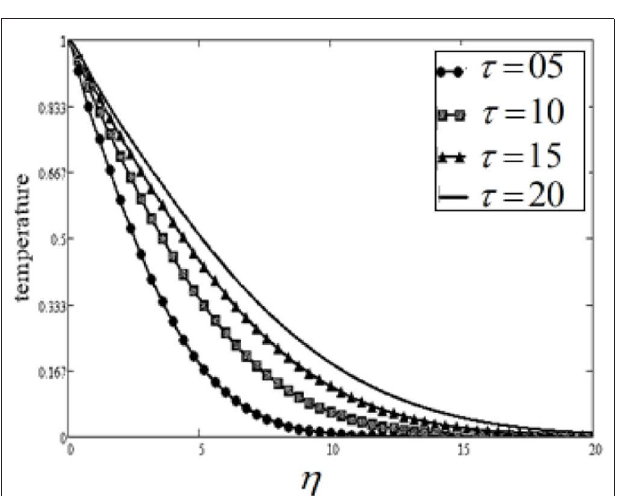
FIGURE 4 | Temperature plot for τ .